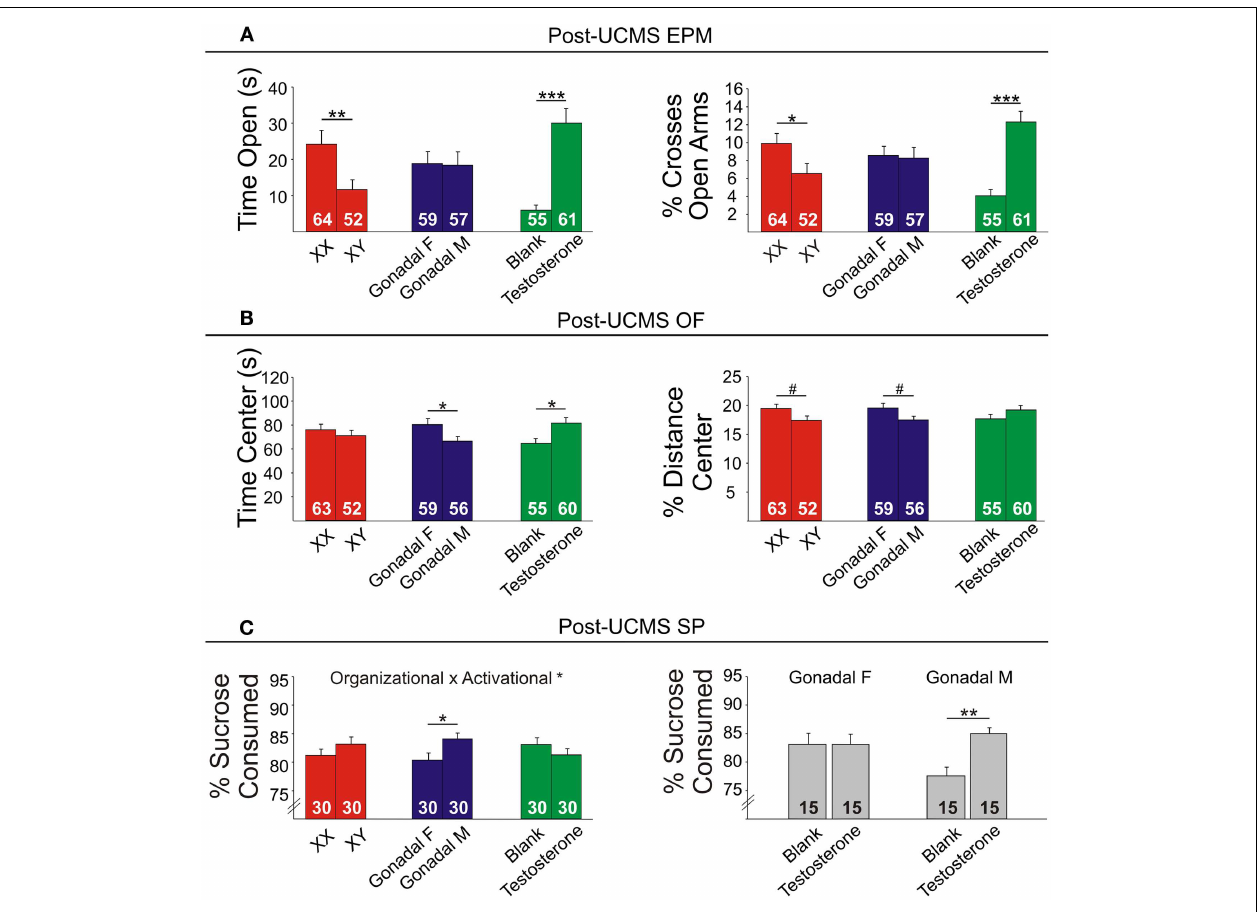
preference (SP) results for percent sucrose consumed for all groups (left) and for the organizational × activational interaction (right). Numbers at the base of bars indicate group sizes. Error bars indicate mean ± SEM. *** p < 0.001, ** p < 0.01; * p < 0.05; # p <